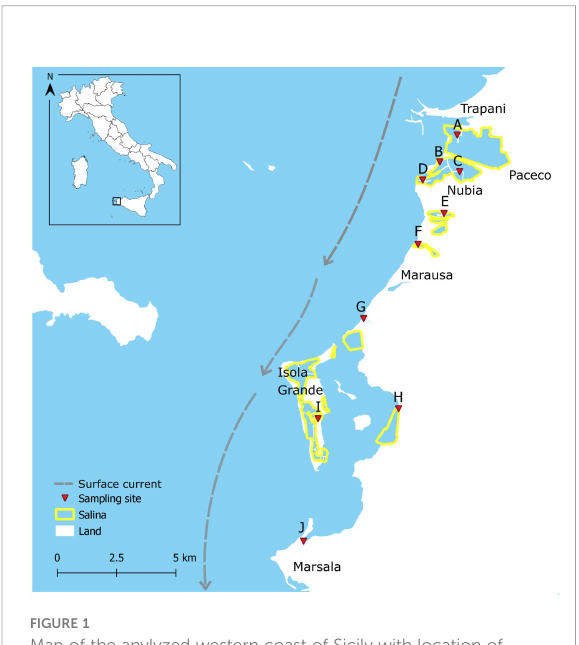
FIGURE 1 Map of the anylyzed western coast of Sicily with location of sampled Ruppia spiralis populations (indicated with red triangles). Dashed lines are the main surface